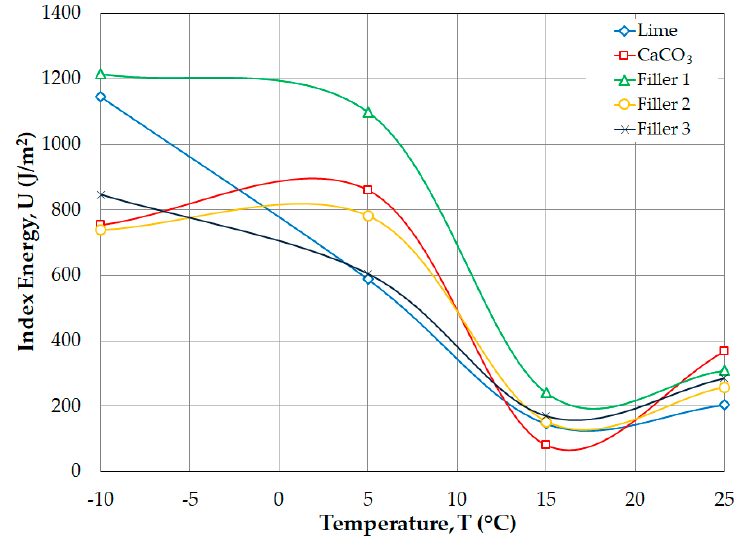
Figure 8. Index energy ( U ) as a function of test temperature. Materials 2018 , 11 , x